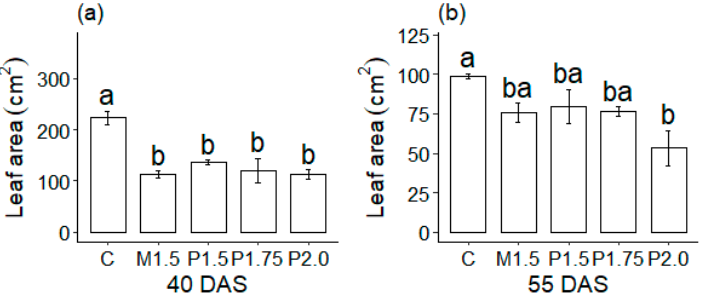
Figure 3. Effect of pendimethalin rates (P1.5, P1.75, P2.0 kg a.i. ha − 1 ), treated control with S -metolachlor at 1.5 kg a.i. ha − 1 (M1.5) and untreated control (C) on barnyard leaf area at 40 DAS ( a ) and 55 DAS ( b ). ‘ns’ means not significant, while means of the same letters are not significantly different at p < 0.05; error bars represent the standard error.